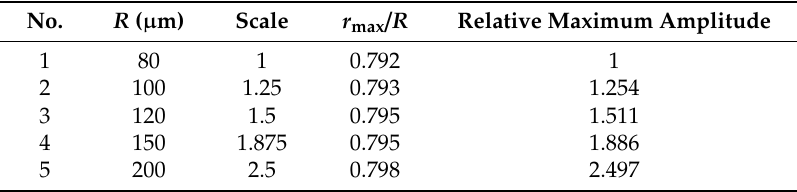
Table 7. The maximum amplitude of bionic structures for di ff erent scales.